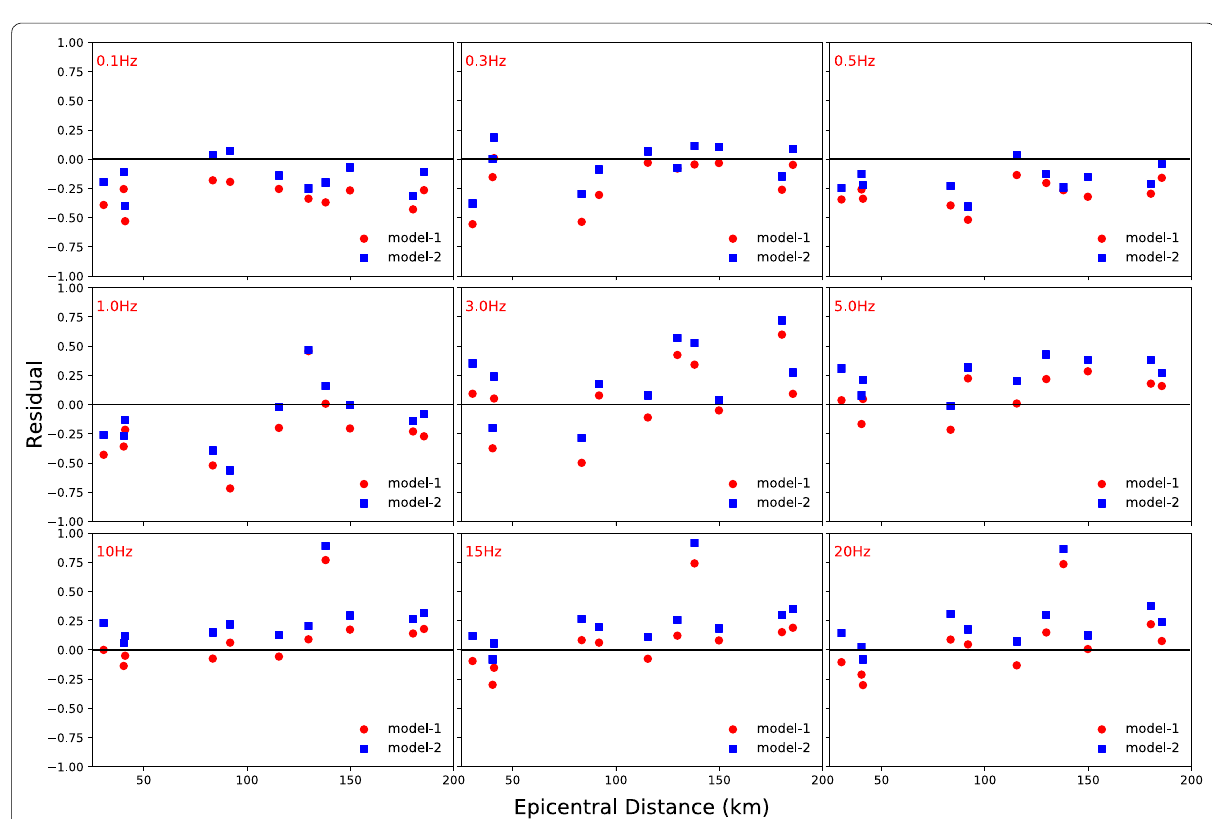
Fig. 9 Model residuals as a function of fault distance for selected spectral frequency. The red and blue cycles are the model residuals from slip model 1 and model 2,